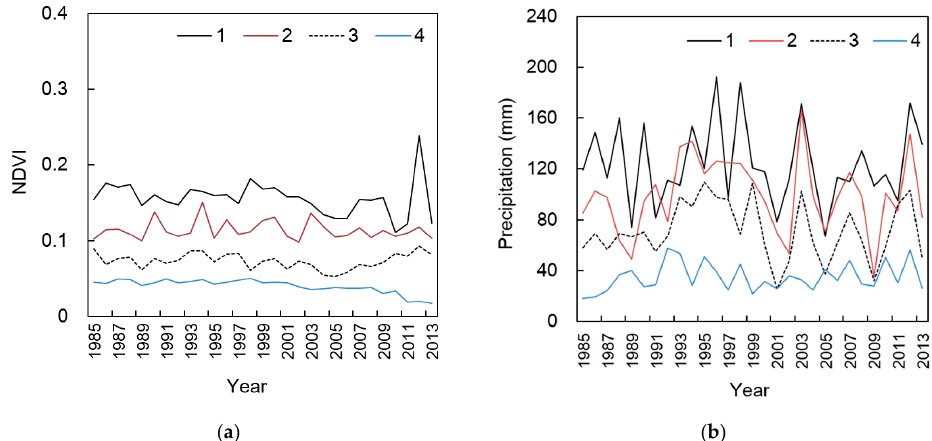
Figure 4. Time series of average GS (the Growing season for plants; from May to September) NDVI for selected sites across the Gobi region and cumulative GS precipitation during the same period ( a , b ). All sites, excluding site 4, exhibit a similar trend of precipitation variation over time ( a ). Site 4 shows